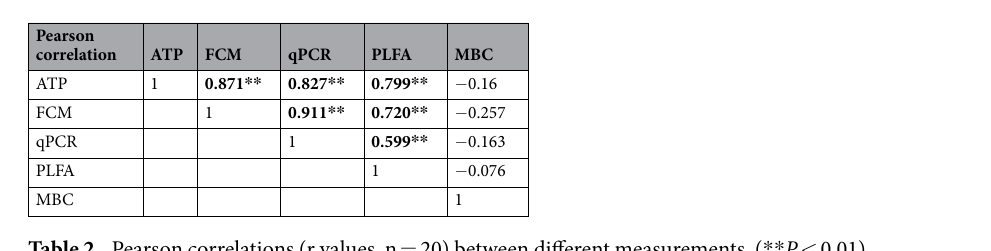
Table 2. Pearson correlations (r values, n = 20) between different measurements. ( ** P <